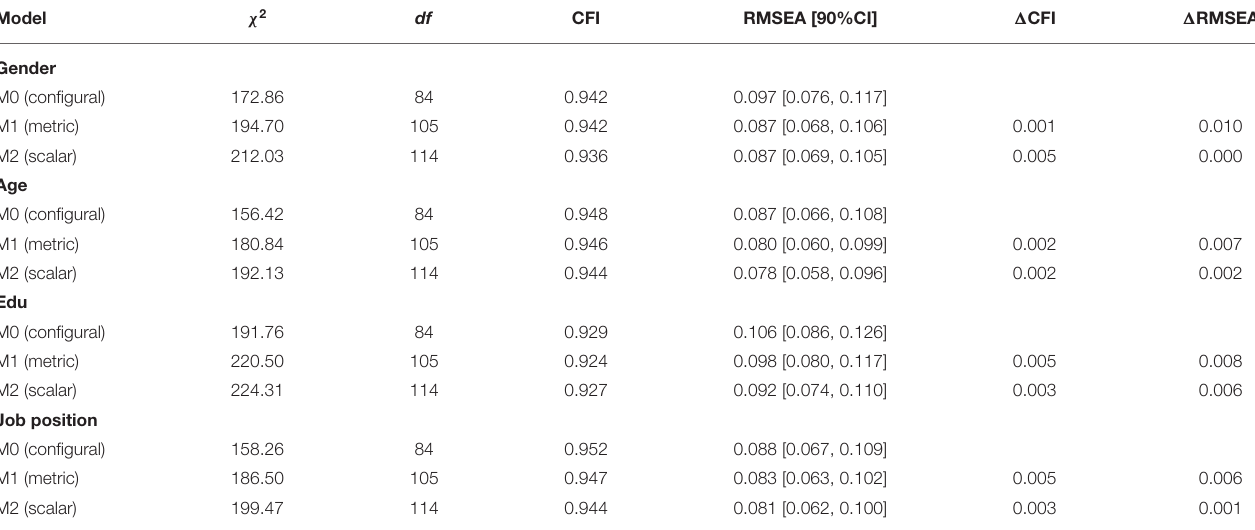
TABLE 4 | Test of measurement invariance of the bifactor model across gender, age, education, and job position in Sample B.